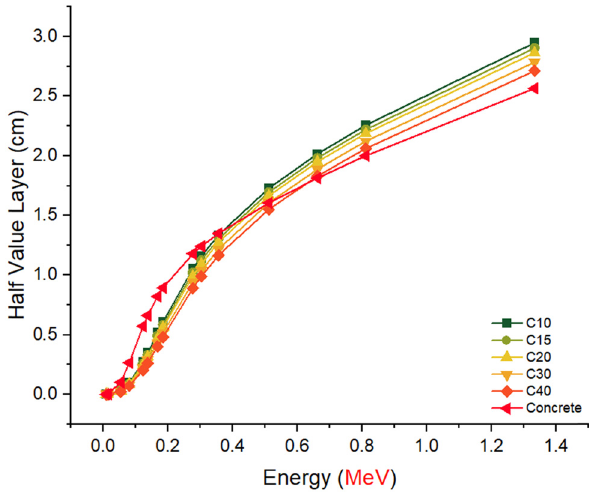
Figure 5: Variations of half value layer ( cm ) with photon energy ( MeV ) for all C0 – C8 glasses and